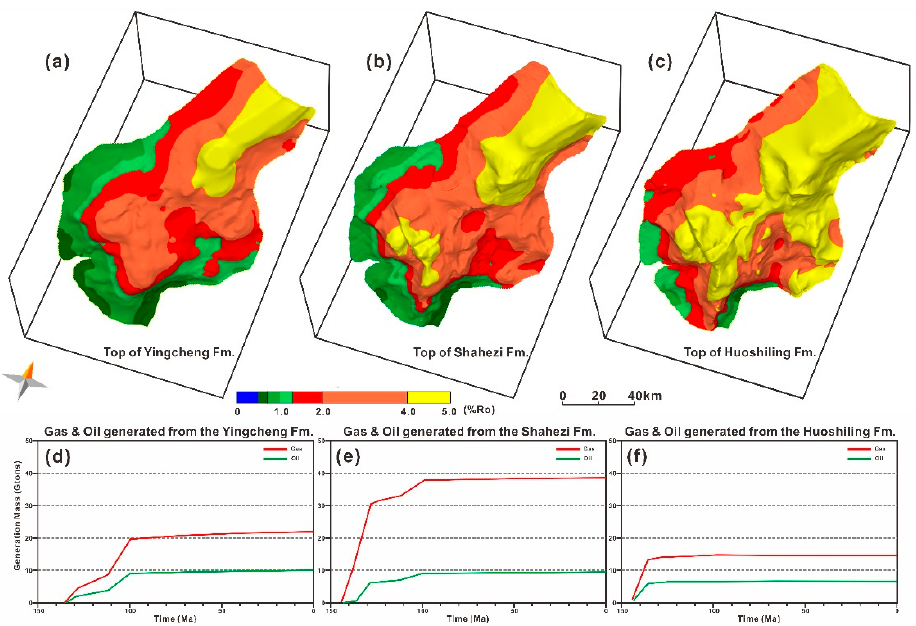
Figure 15. Maturity distribution and hydrocarbon generation from the main source rocks in the Changling Depression. ( a ) Present day maturity maps for K 1 y. ( b ) Present day maturity maps for K 1 sh. ( c ) Present day maturity maps for J 3 h. ( d ) Generation mass of gas (red curve) and oil (green line) from K 1 y. ( e ) Generation mass from K 1 sh. ( f ) Generation mass from J 3 h.